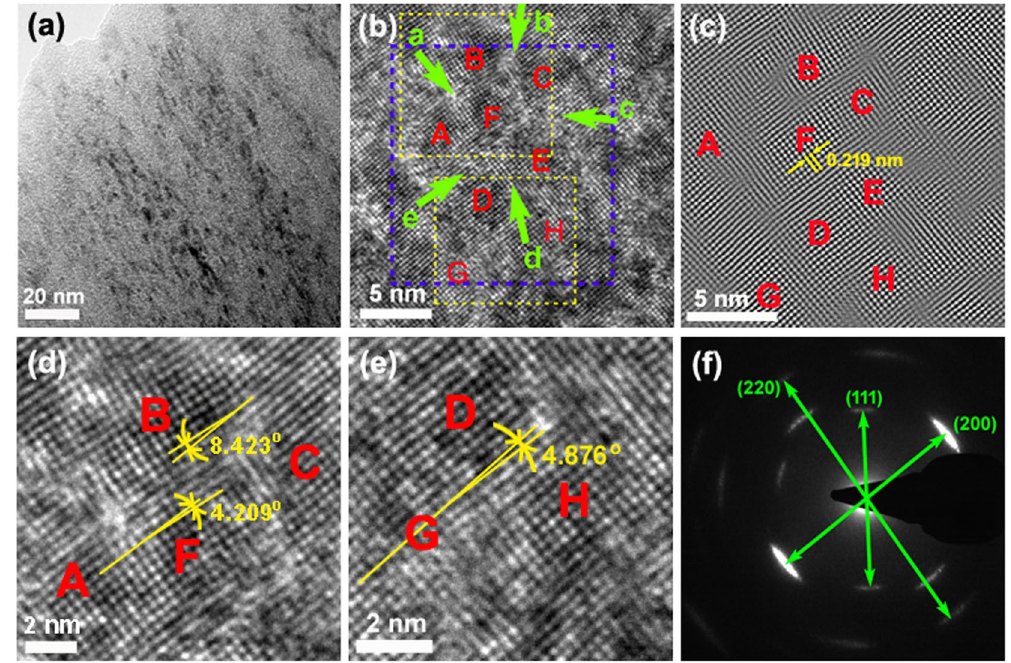
Figure 3. Cross-sectional HRTEM images of the TiSiCN nanocomposite film with the C/Si content ratio of 2:2. ( a ) Low magnification. There exist many nano-sized equiaxed grains with the dark contrast within the elongated grains. ( b ) High magnification. The nanocomposite structure is created with the equiaxed nanocrystallites surrounded by the interfaces. The epitaxial growth structure between the nanocrystallites and interfaces is basically revealed. ( c ) Inverse fast Fourier transformation micrograph of the area marked by the blue frame in ( b ). ( d ) and ( e ) the magnified images from the upper and lower yellow dashed line areas in ( b ), indicating that the small growth misorientations can be found between the adjacent nanocrystallites. ( f ) Selected area electron diffraction patterns.